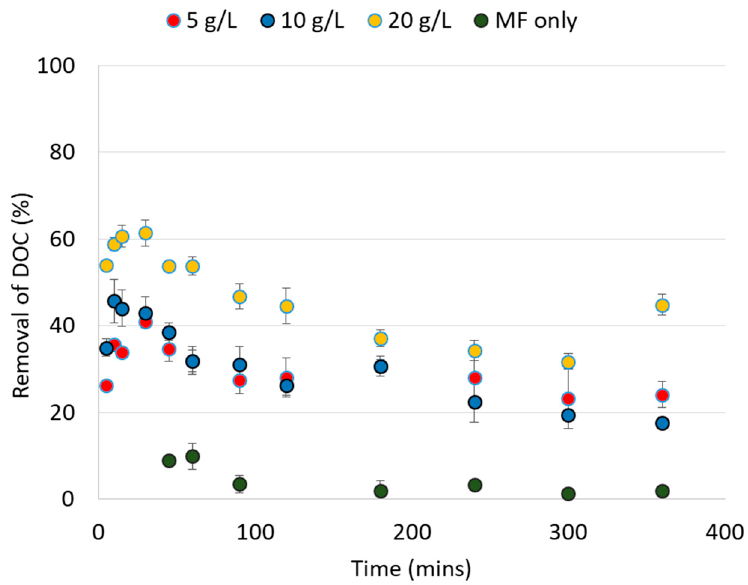
Figure 2. The removal of DOC with the MF–IEX hybrid system for the varying doses of Purolite ® A502PS (0, 5, 10, 20 g/L). Some error bars are obscured by the symbol due to its size.